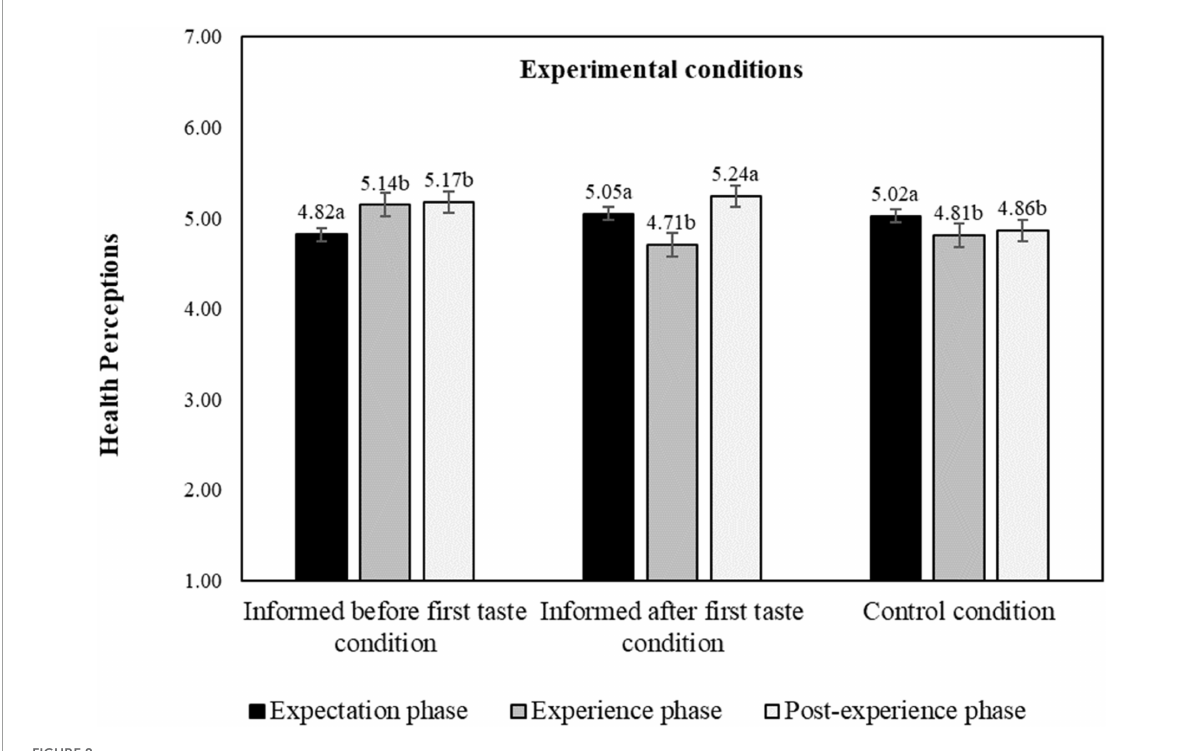
FIGURE8 Interaction effect of experimental conditions and product evaluation phase on health perceptions, estimated marginal means. a–c: means with different letters are significantly different at p < 0.05 level; health perceptions measured on a 9-point hedonic scale. The bars display standard